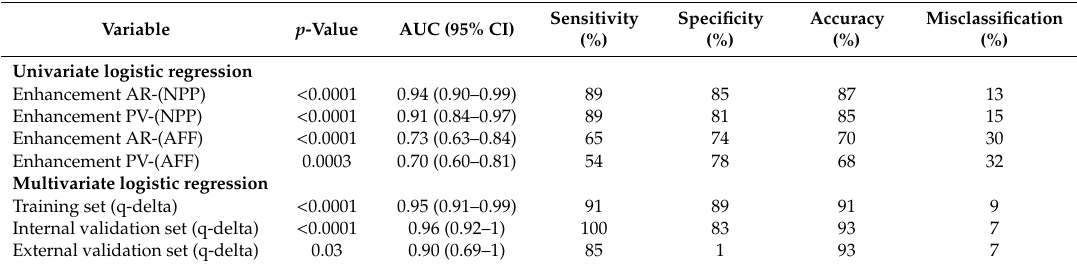
Table 2. Univariate logistic regression analysis of the measured normalized enhancement values using the training data set, followed by multivariate logistic regression using both AR-(NPP) and PV-(NPP) to build and test the predictive